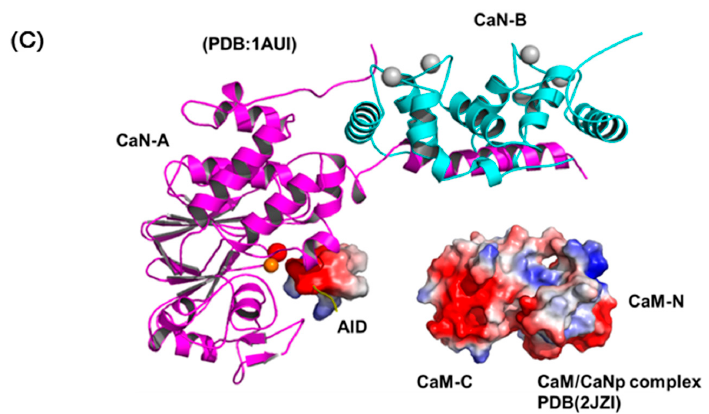
Figure 8. The schematic diagram of the activation processes of CaN. ( A ) Ribbon representation of the structure of human CaN (1AUI). The CaN-B is colored coded in cyan. The catalytic domain, AID of CaN-A is colored coded in magenta and yellow. The region connecting the BBD to AID is invisible in the electron density map (draw in green dashed line). ( B ) The complex formation of CaM and the target sequence of CaN. ( C ) The charge distribution of CaM/CaNp complex and AID. Positive and negative electrostatic charge is colored in blue and red, respectively. Both surfaces are mostly negatively-charged, especially in the C-domain of CaM/CaNp complex. The electrostatic repulsion between CaM/CaNp complex and AID may result in the displacement of AID from active site to full activation.